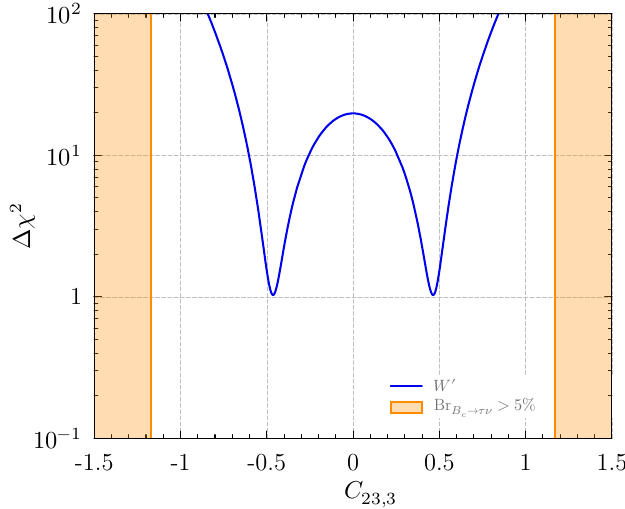
Figure 1 . The (cid:1) (cid:31) 2 distribution (blue) for the (cid:12)t of the R ( D ( (cid:3) ) ) predictions in the Q VR e(cid:11)ective theory, eq. (2.3), to the current world average [7]. Also shown (shaded orange) are exclusion regions for Br( B c ! (cid:28)(cid:23) ) &